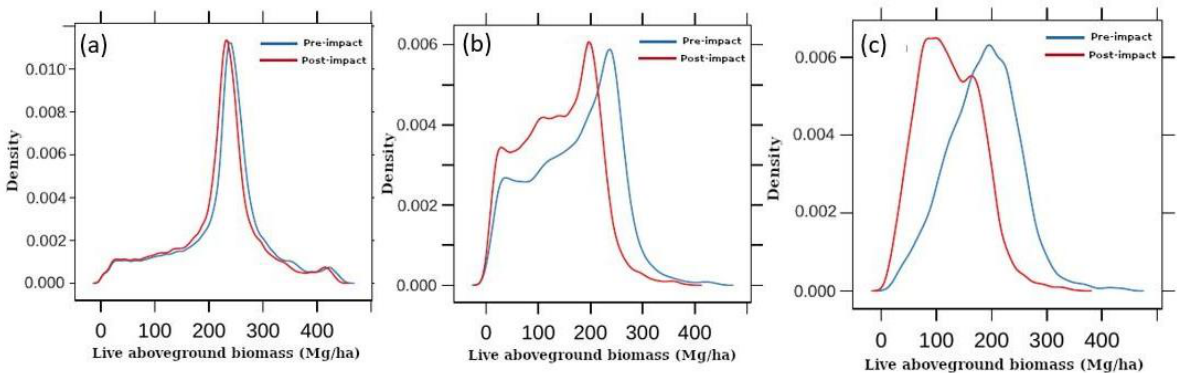
Figure 3. Biomass density plots describing patterns before and after drought ( a ), fire ( b ) and logging + fire ( c ) impacts. Only areas that burned between 2003 and 2016 are considered and, for ( c ), only burned areas up to 3 km from logging areas. Recovery is defined as 100% of pre-disturbance AGB.